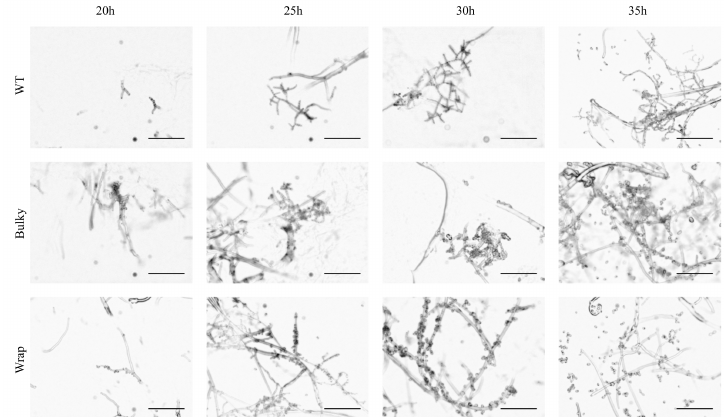
Figure 2. Development of conidiophore architectural phenotypes over time. Individual cultures were imaged at 20, 25, 30 and 35 h after being transferred to a nitrocellulose membrane and placed under light. Development of the conidiophore begins at roughly 20 h and concludes with sporulation by 35 h. Representative strains used were as follows: WT, FGSC2489; Bulky, FGSC8879; Wrap, FGSC8876. Scale bar, 100 µ